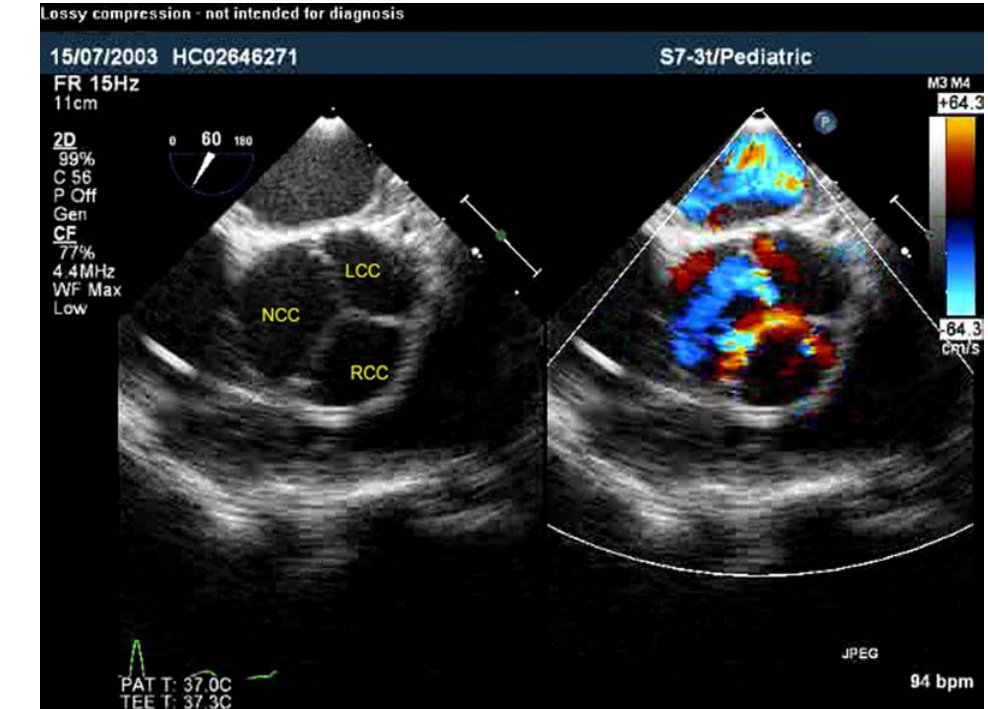
Figure 1. Short axis view of the aortic valve showing the dilated non coronary cusp (NCC), the right coronary cusp (RCC) and the left coronary cusp